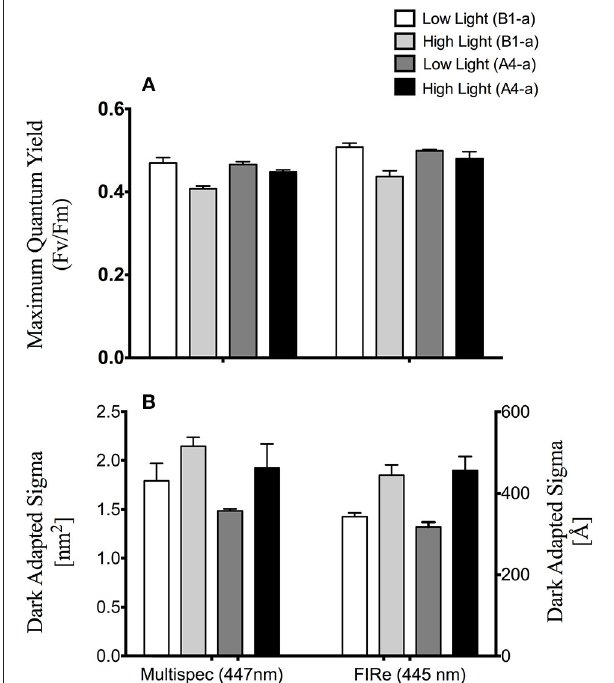
FIGURE 6 | Comparison of open source and FIRe fluorometers. (A) Average maximum quantum yield of PSII (Fv/Fm) and (B) functional absorption cross section of PSII ( σ PSII ). Left and right axes reflect σ PSII units for the open-sourced and FIRe fluorometers respectively. Error bars represent ± SE.